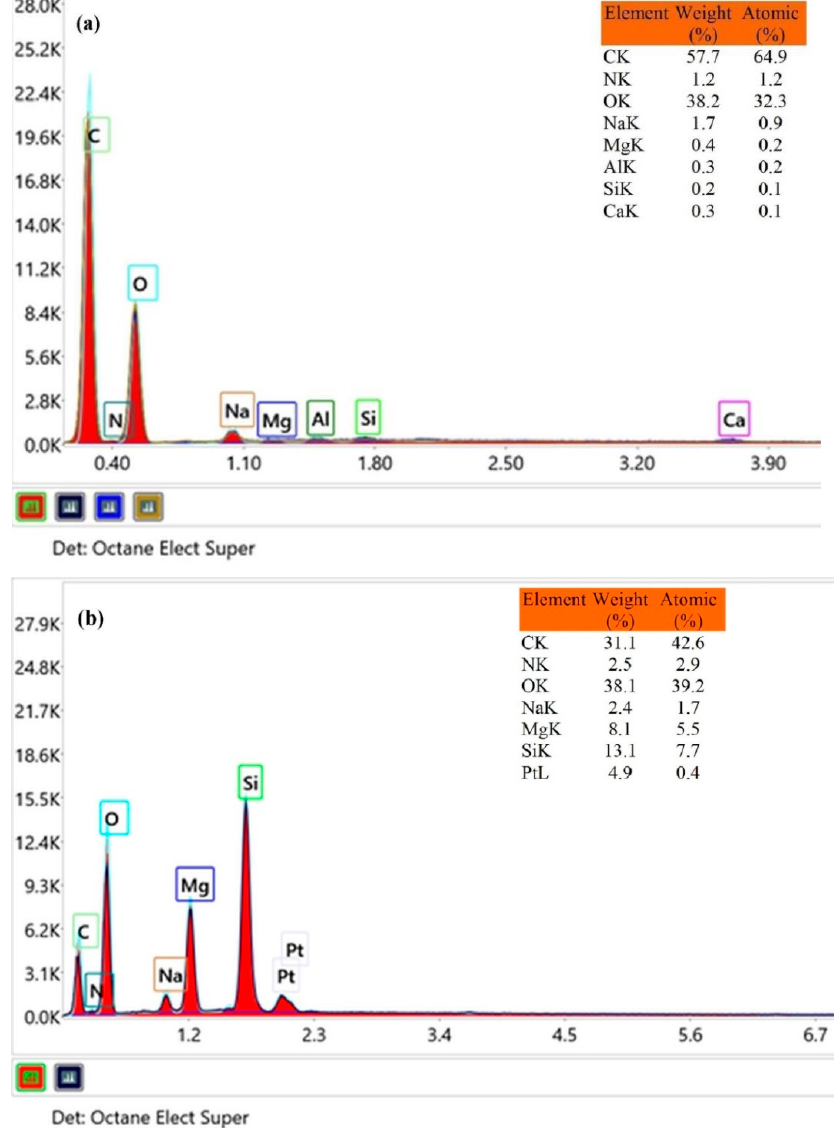
Figure 6. EDX analysis of samples ( a ) C1 and ( b )